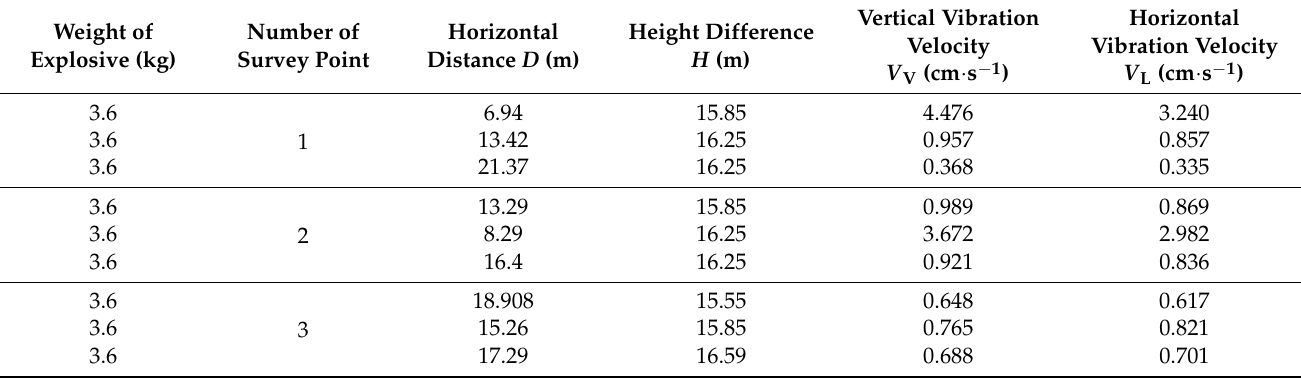
Table 1. The data collected in the